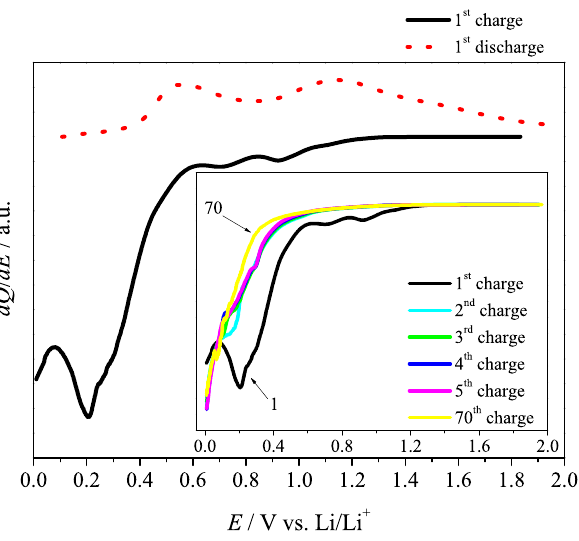
Figure 7. Differential capacity plot (dQ/dE) of lithiation and delithiation for the first cycle of SnO x /CHI electrode material. Inset: dQ/dE for cycles 1–5 and